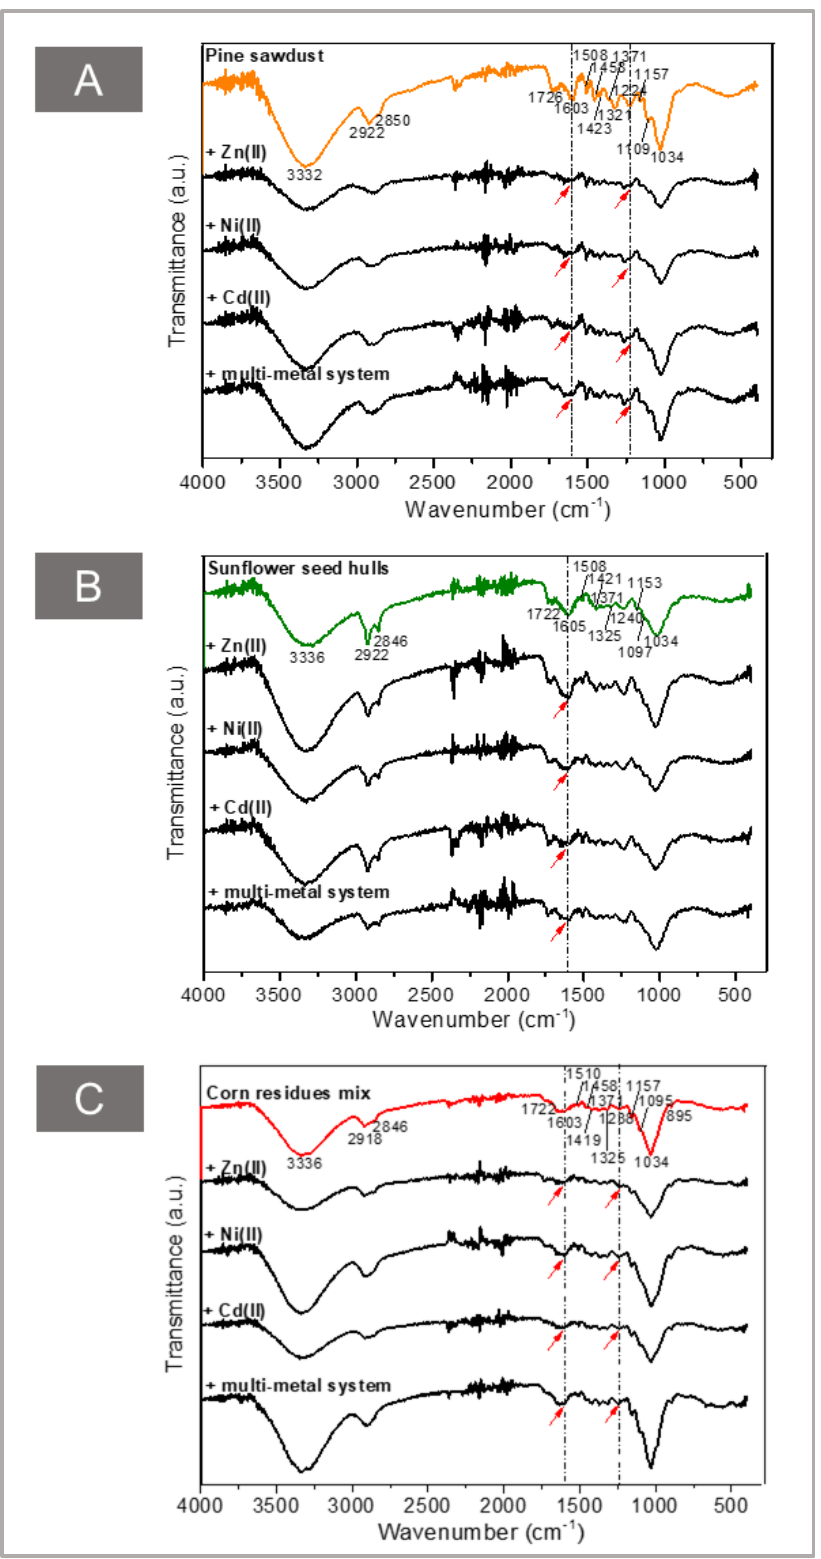
Figure 5. ATR-FTIR spectra of: ( A ) pine sawdust, ( B ) sunflower seed hulls, ( C ) corn residues mix, before and after the adsorption process.